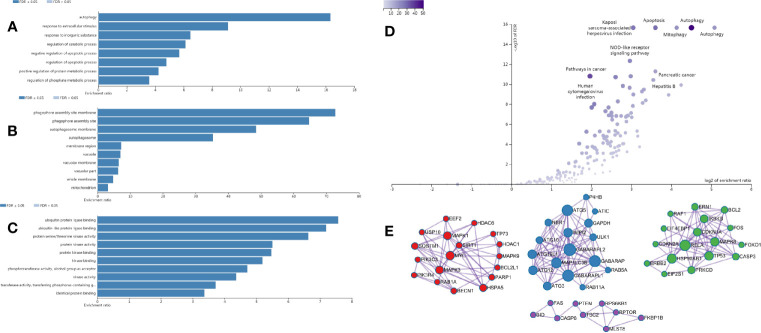
Enrichment analysis results of DEAGs in CRC from the WebGestalt website. (A) The biological process of GO analysis in CRC. (B) The cellular component of GO analysis in CRC. (C) The molecular function of GO analysis in CRC. (D) The signaling pathway of KEGG analysis in CRC. (E) The protein-protein interaction network of DEAGs in CRC.